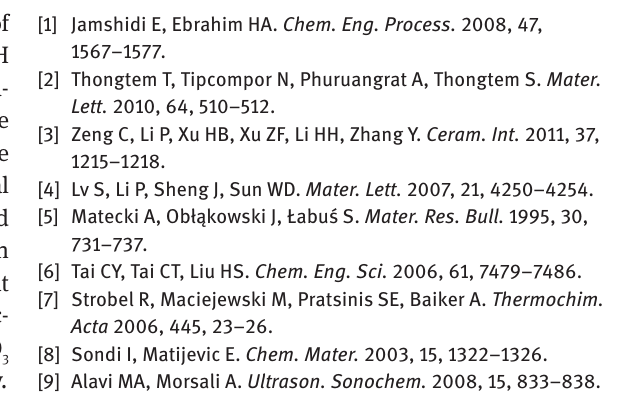
reaction of β -type BaCO second endothermic peak at 959.7 ° C. The TG curve of the